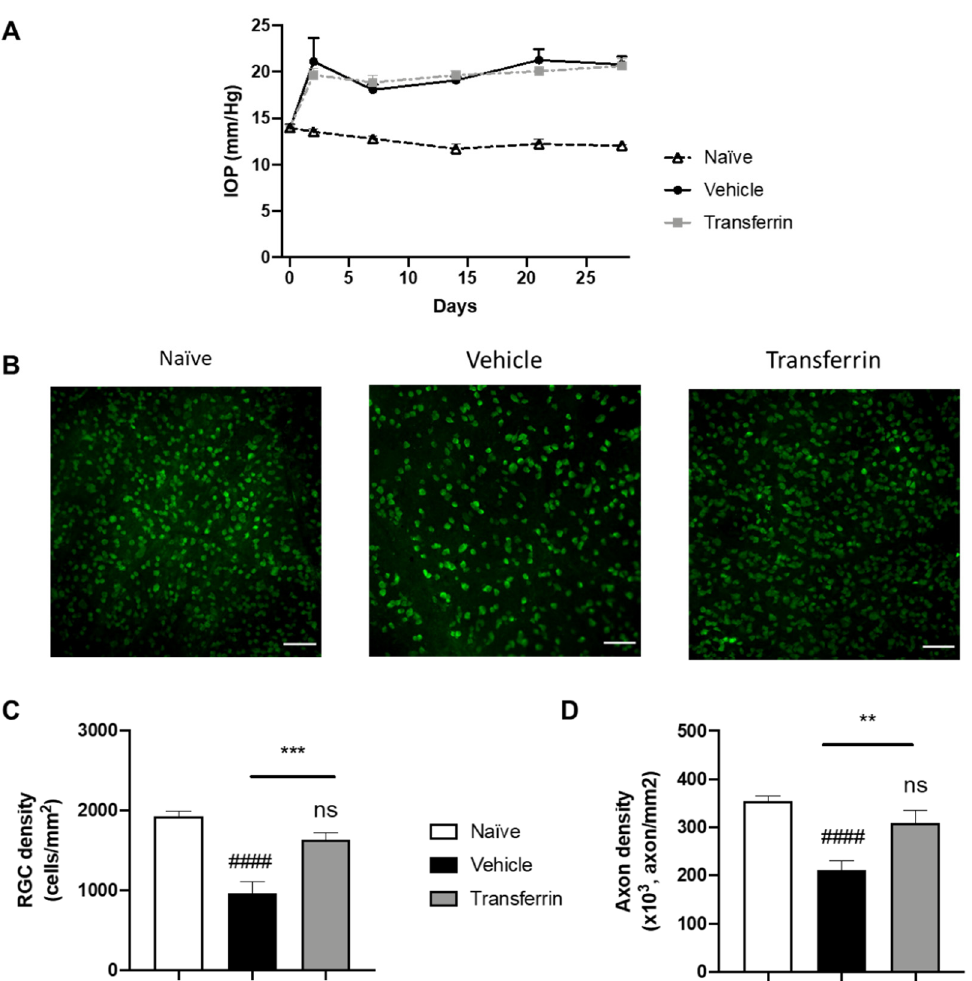
Figure 4. Transferrin prevents retinal ganglion cell death and axon loss in rats exposed to ocular hypertension. ( A ) Rats were injected with microbeads in the anterior chamber on day 0. IOP remained significantly elevated over the four-week period of the study beginning at 48 h after OHT when compared to normotensive naïve animals. IOPs were not statistically different in vehicle- and TF- treated groups. ( B ) Representative micrographs of flat-mounted retina sections labeled for the RGC marker RBPMS. ( C ) Mean RGC density per mm 2 in the vehicle group was significantly reduced when compared with control animals (naïve group). TF significantly preserved RGC. ( D ) Axon density in optic nerves from vehicle-treated group was significantly lower than naïve. There was no difference in axon density between the TF treatment and naïve optic nerves. Data represent means ± SEM, n = 10 per group. Statistics are one-way ANOVA followed by Tukey’s multiple comparisons test. Symbols above the bars are comparisons with naïve control group. ns, not significant; #### p < 0.0001 compared to naïve control group. ** p < 0.01; *** p < 0.001 compared to vehicle-treated